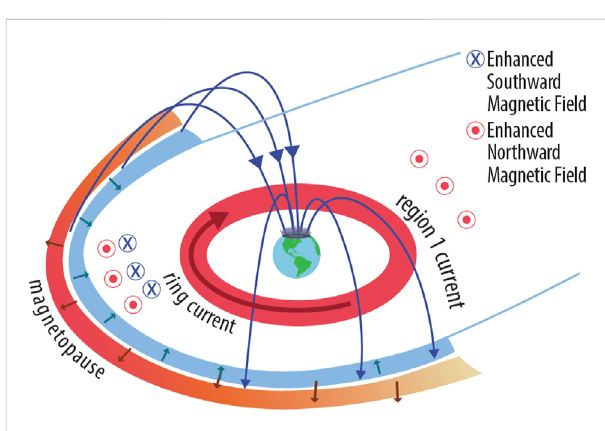
FIGURE 7 The large-scale region one and ring current systems and their resulting magnetic fi eld perturbations. STORM quanti fi es the inward magnetopause erosion associated with reconnection and region one currents, the outward magnetopause motion associated with enhanced ring current strengths, and the ring current ’ s effect on the nightside magnetic fi eldsthatcontroltheoccurrenceofreconnection in the tail in order to determine how the energization of the inner- magnetosphere affects the outer